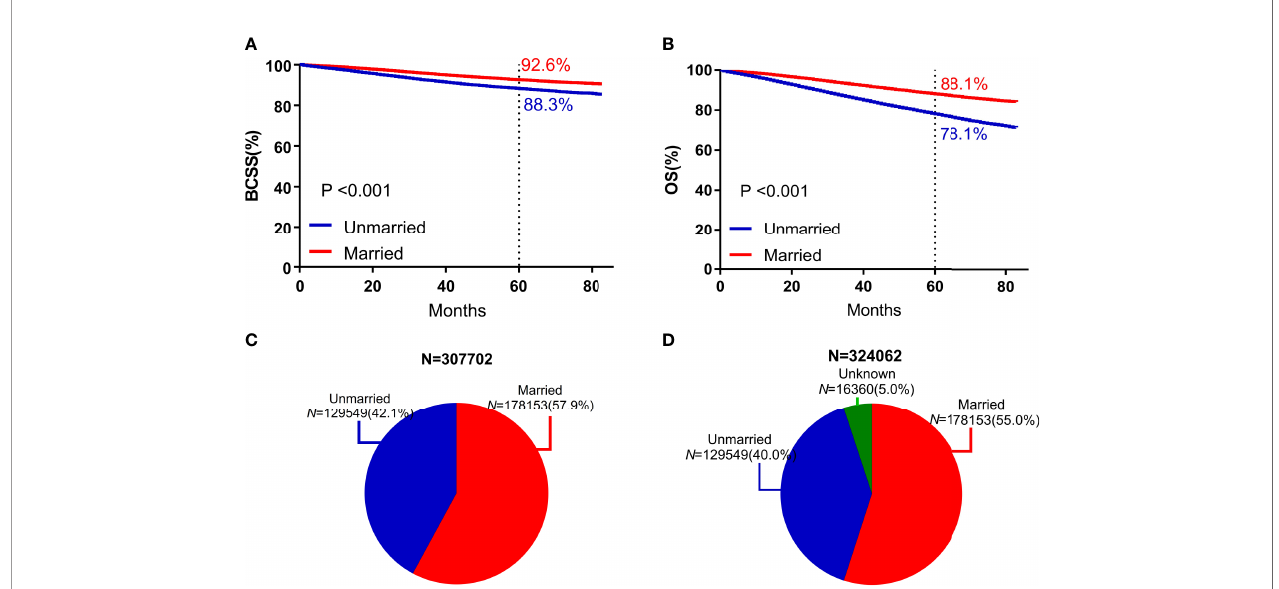
FIGURE 2 | Survival curves and subject proportions according to marital statuses. BCSS (A) and OS (B) according to marital statuses were depicted. Subject proportions according to marital statuses without the unknown marital status (C) and with the unknown marital status (D) were also depicted.